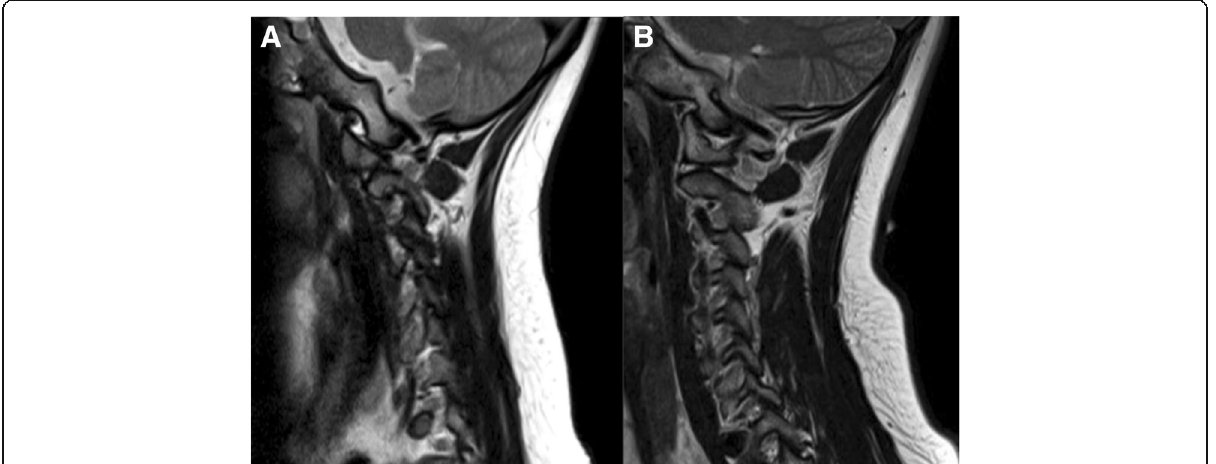
Fig. 13 a Sagittal T2/TSE of a 12-year-old Down syndrome patient showing a small and flattened shape of the occipital condyle as well as the C1